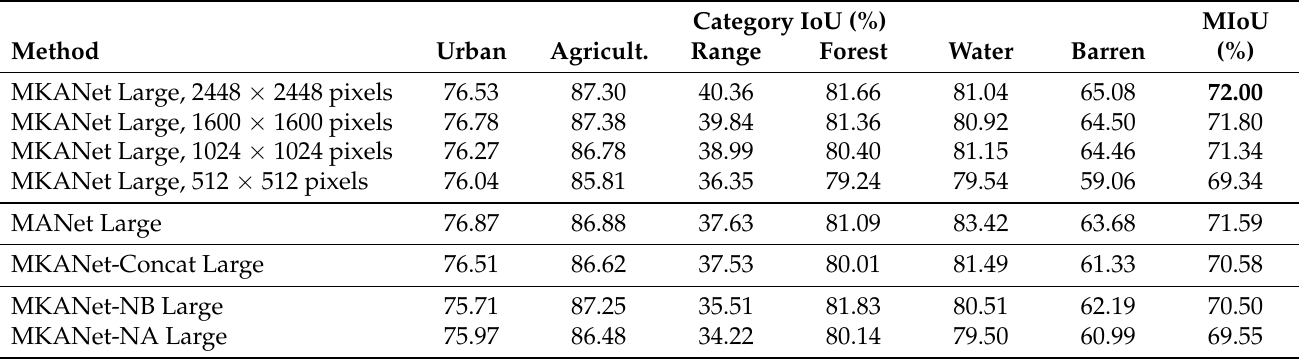
Table 8. Comparison of different variants.